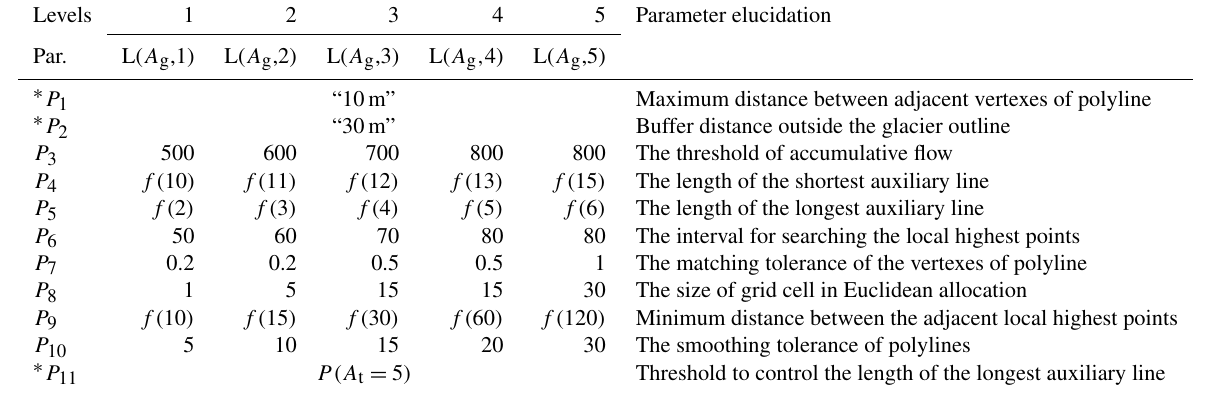
Table 1. The description of adjustable parameters. Levels 1 2 3 4 5 Parameter elucidation Par. L( A g ,1) L( A g ,2) L( A g ,3) L( A g , 4) L( A g ,5) “10m” Maximum distance between adjacent vertexes of polyline ∗ P “30m” Buffer distance outside the glacier